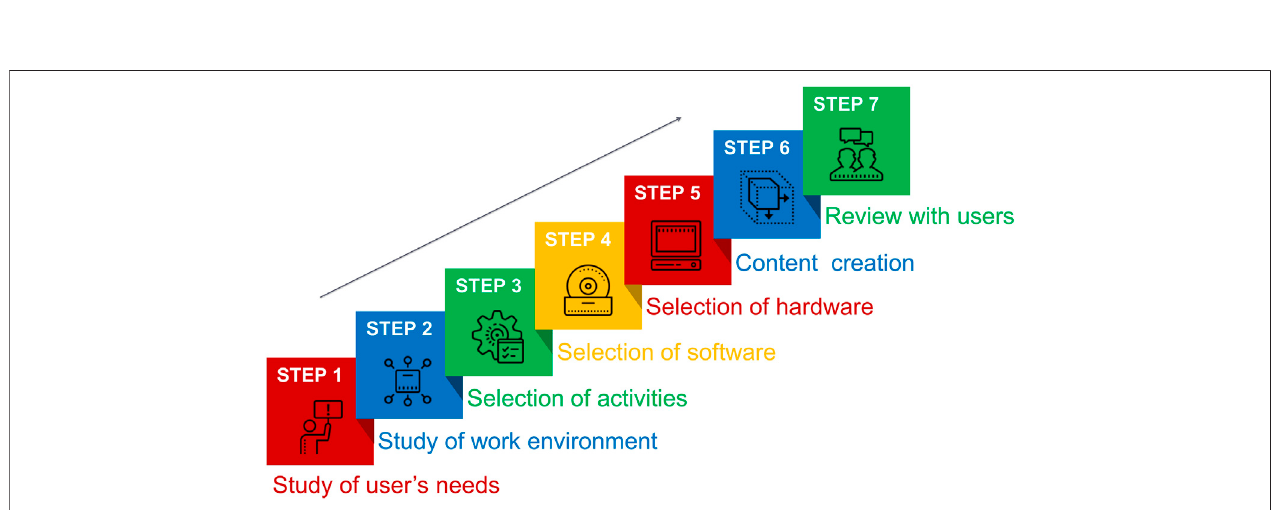
FIGURE 7 | Main steps for the deployment of an AR app in